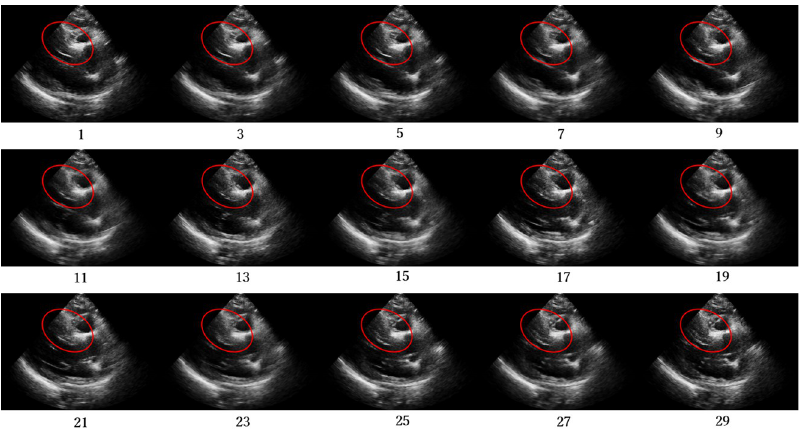
Fig 18. False-negative cases on long-axis view images with anteroseptal infarction with regional abnormal wall motion circled in